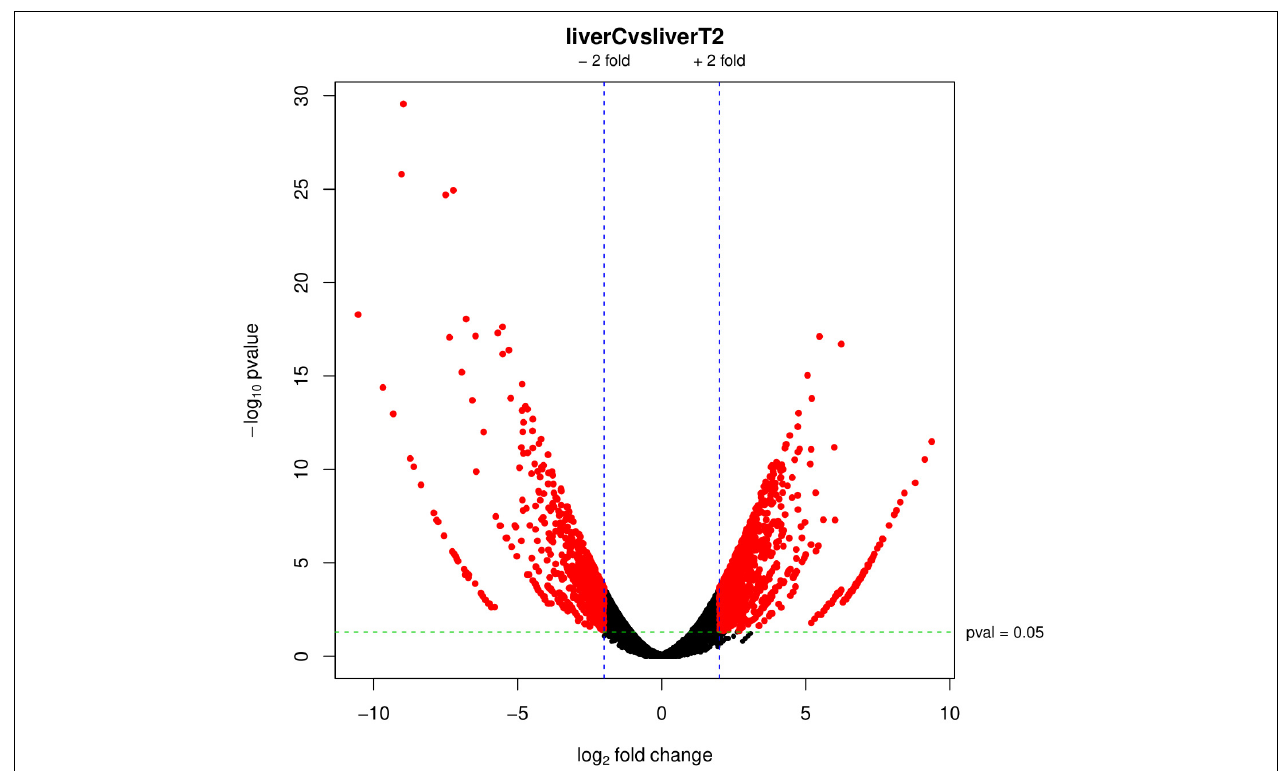
FIGURE 7 | Volcano plot. Red dots represent differentially expressed genes according to the p -adj and logFC cut-off values.